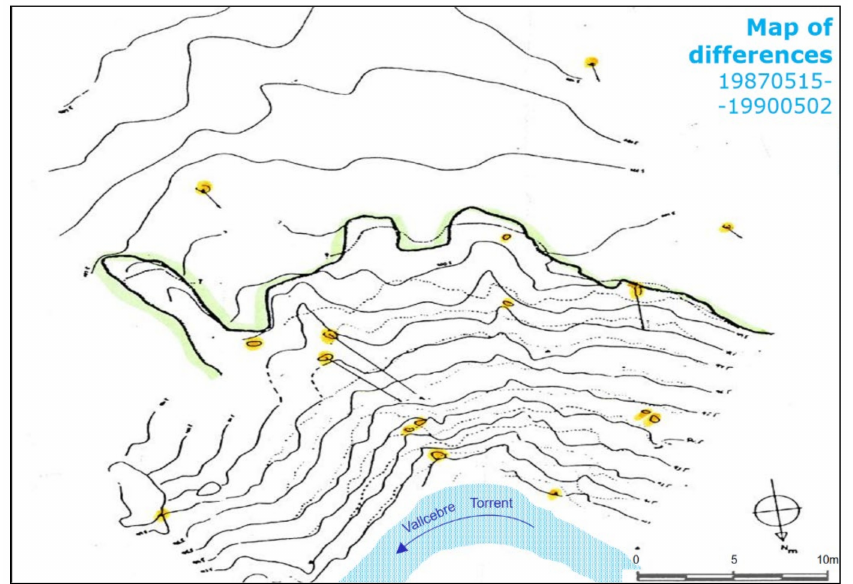
Figure 5. Terrestrial photogrammetry sample result: Map of differences between two campaigns (one-meter contour-line interval) at the landslide toe (Figure